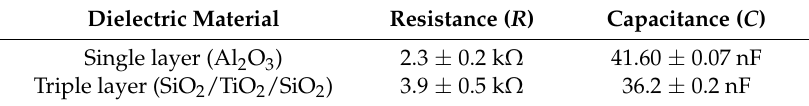
Table 6. Main features obtained from low frequency impedance fitting curves of the manufactured